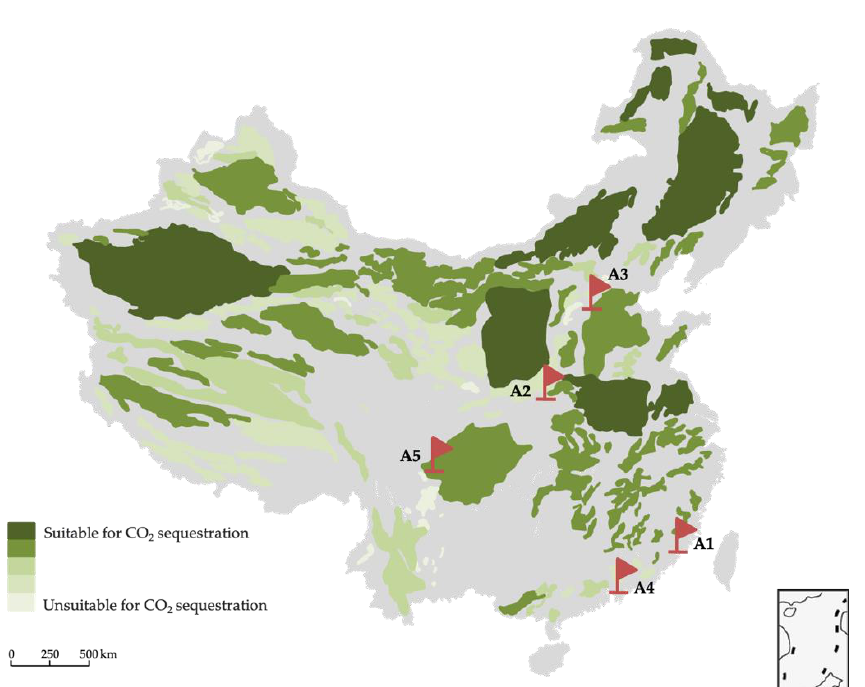
Figure 4. Geological storage conditions for CO 2 in China and possible sites for NZCEP plants. A1–A5 are potential construction sites for NZCEP plant. Jinjiang, Fujian Province (A1); Zhengzhou, Henan Province (A2); Chaoyang District, Beijing (A3); Huizhou City, Guangdong Province (A4); and Ziyang City, Sichuan Province (A5).